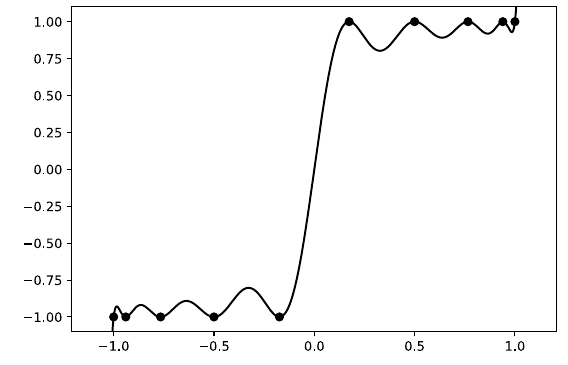
FIG. 3. Example of the Hermite interpolating polynomial for L = 9. The points are given by Eq. (29), and all of their deriva- tives are set to zero except for the leftmost and rightmost